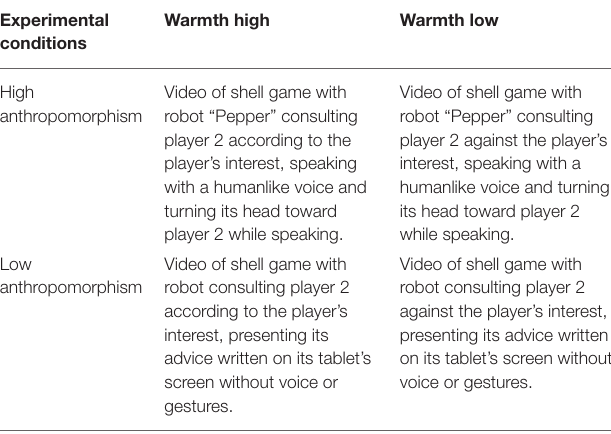
TABLE 6 | Descriptions of experimental conditions in study